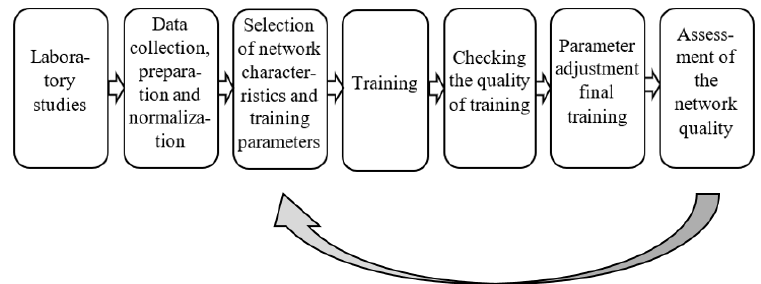
Figure 2. Research algorithm.